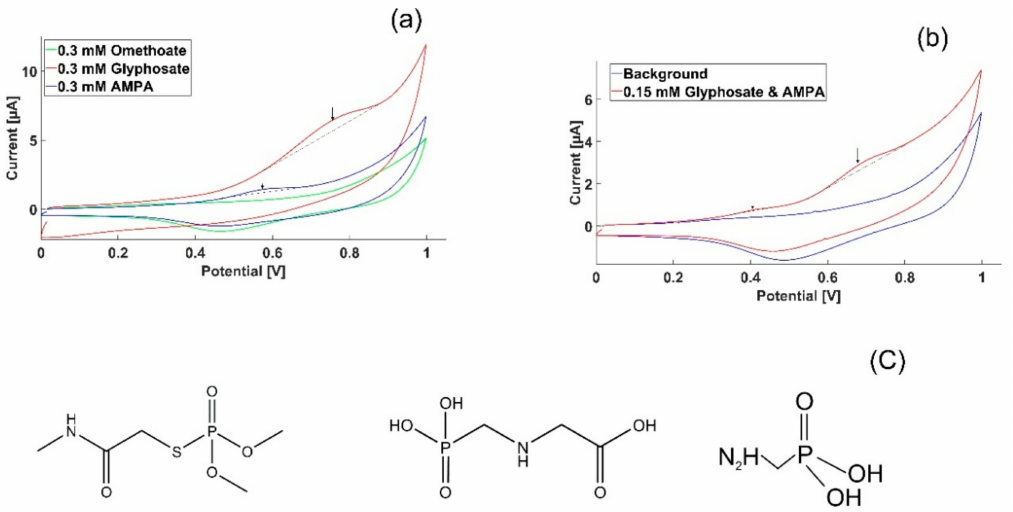
Figure 4. Interference signal from different compounds with a similar structure to Gly.